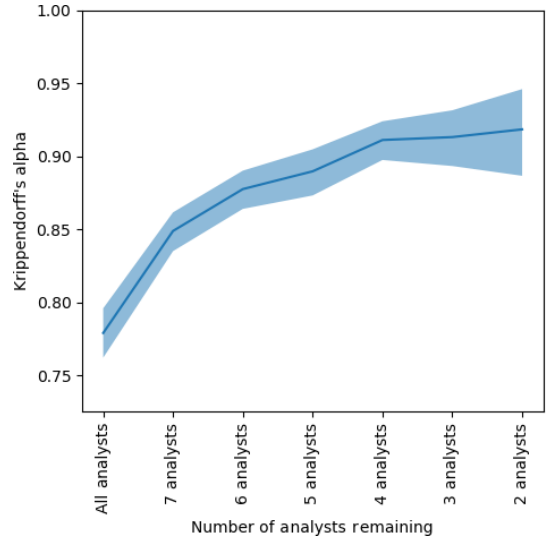
Figure 18. The agreement (Krippendorff’s alpha) found by sequen- tially removing each analyst from the group whose absence in- creased alpha the most. The vertical axis shows Krippendorff’s al- pha. The horizontal axis shows the number of analysts remaining in the group considered – that is, the first entry on the left shows the Krippendorff’s alpha when all eight analysts were included, the sec- ond entry shows Krippendorff’s alpha when the analyst whose esti- mates disagreed the most was removed, etc., until only the two an- alysts whose ice concentration estimates that agreed the most with one another remained. The shaded region indicates the upper and lower bounds of the 95% confidence